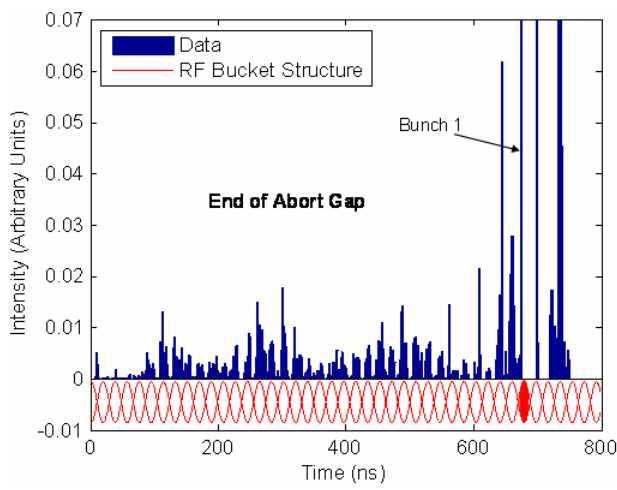
FIG. 9. (Color) Structure of the beam in the tail end of the abort gap. Blue bars represent proton intensity; red curves are given for reference and show the Tevatron rf buckets.